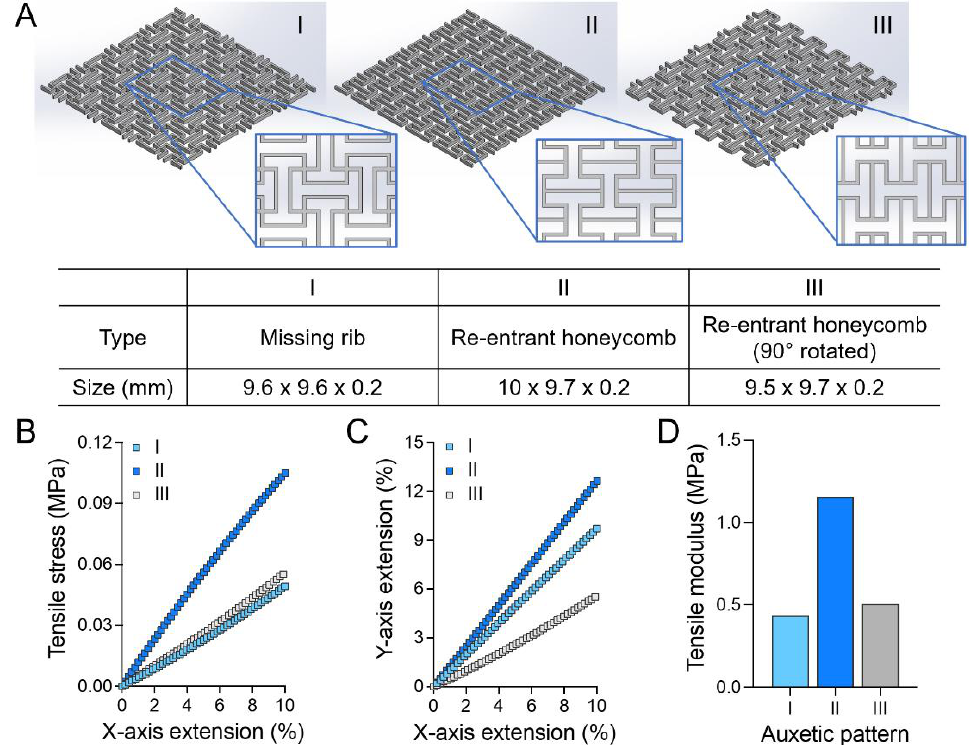
Figure 1. Finite element analysis of auxetic patches for the three different patterns. ( A ) Auxetic patch structures of orthogonal missing rib ( I ), 0° ( II ), and 90° ( III ) rotated re-entrant honeycomb; ( B ) Stress–strain and ( C ) X vs. Y extension curves of auxetic patches; ( D ) Tensile modulus of auxetic patches by patterns.